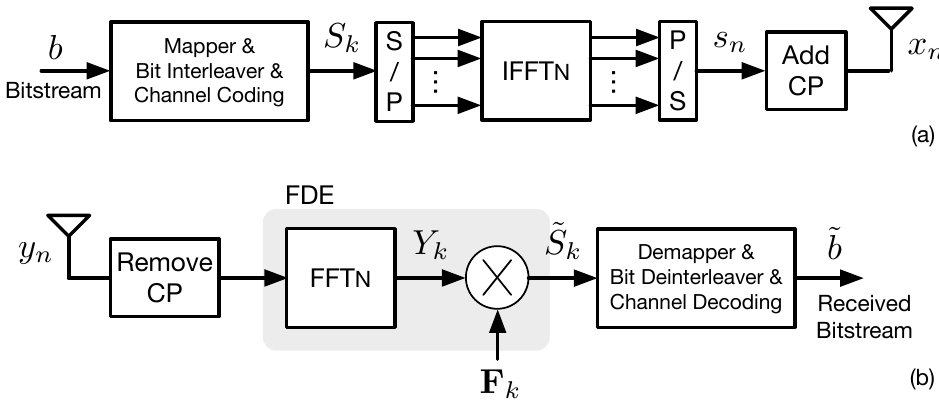
Figure 1. OFDM transmitter ( a ) and receiver ( b